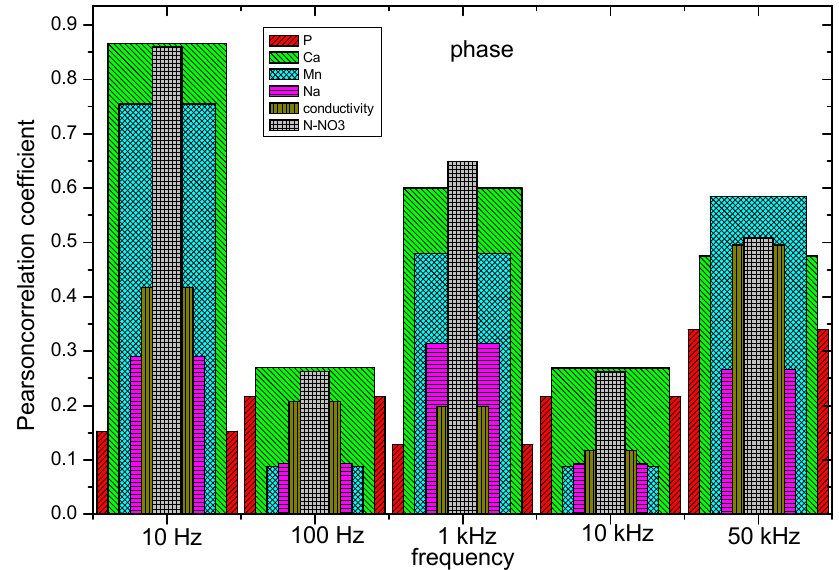
Figure 16. Pearson correlation coefficient of P, Ca, Mn, Na, conductivity, and N 2 -NO 3 with respect to